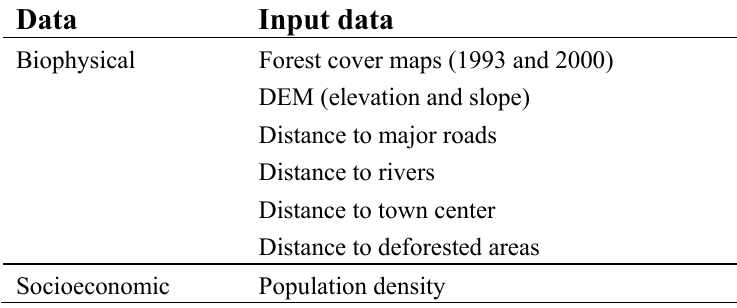
Table 1. Initial input data for simulating forest cover